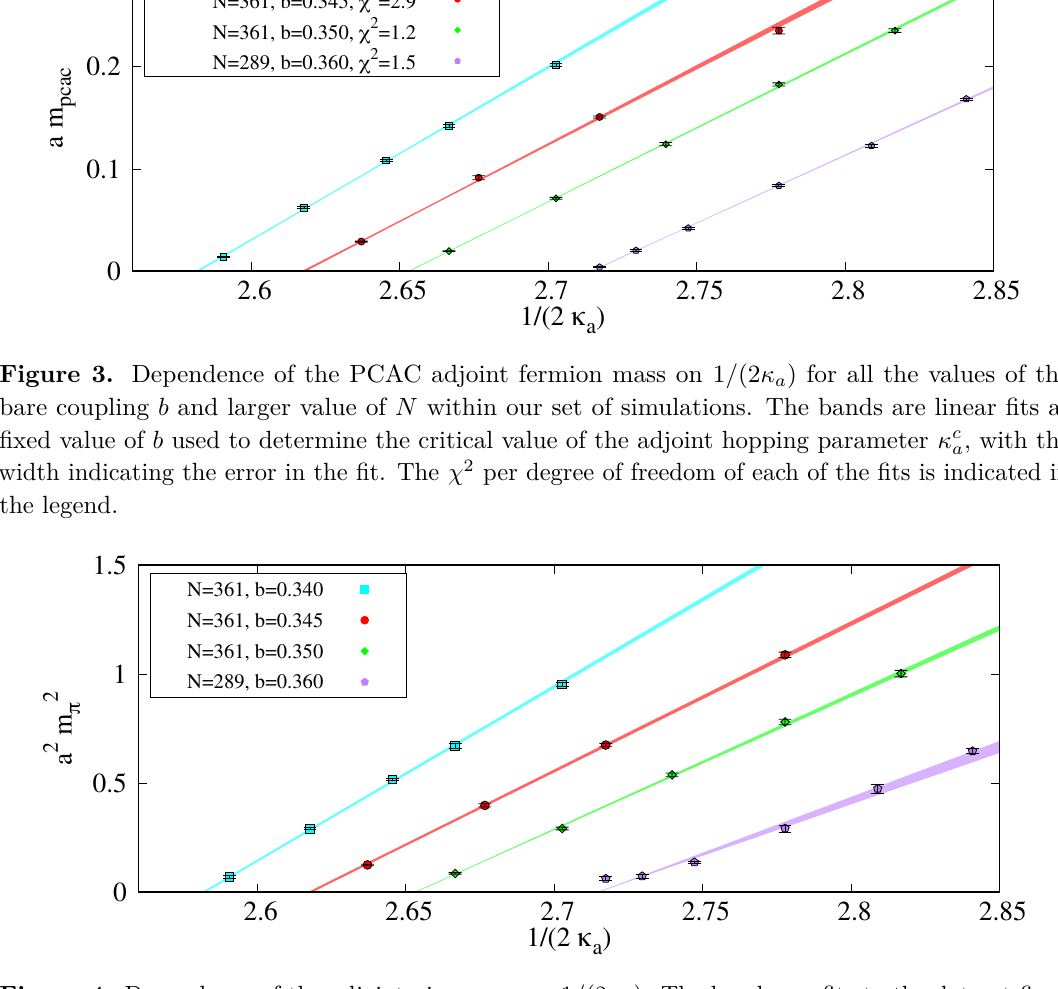
Figure 4. Dependence of the adjoint pion mass on 1 / (2 κ a ) . The bands are fits to the data at fixed value of b with the critical hopping parameter fixed to the one extracted from the vanishing of the PCAC mass, as detemined from figure